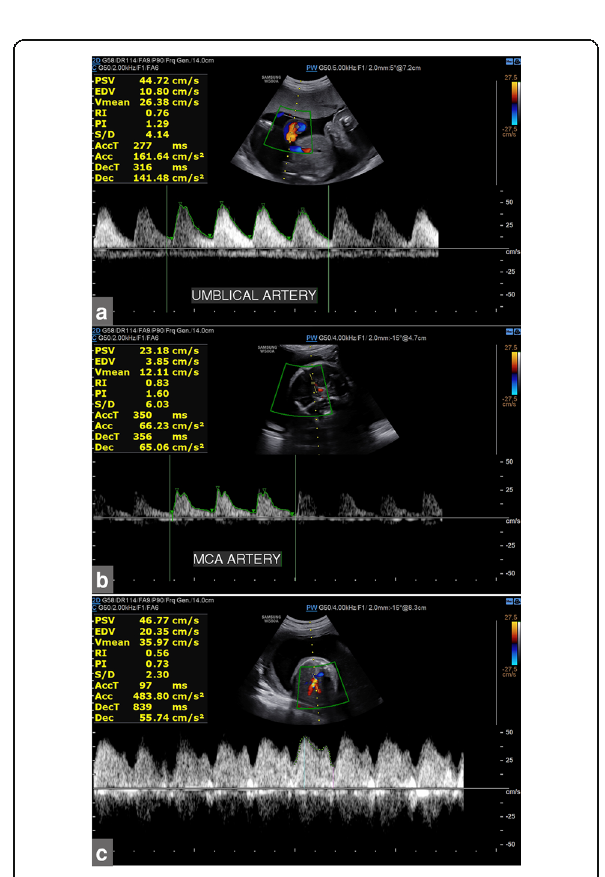
Fig. 2 Normal fetal Doppler parameters such as umbilical artery ( a ), middle cerebral artery ( b ) and ductus venosus ( c ) in pump